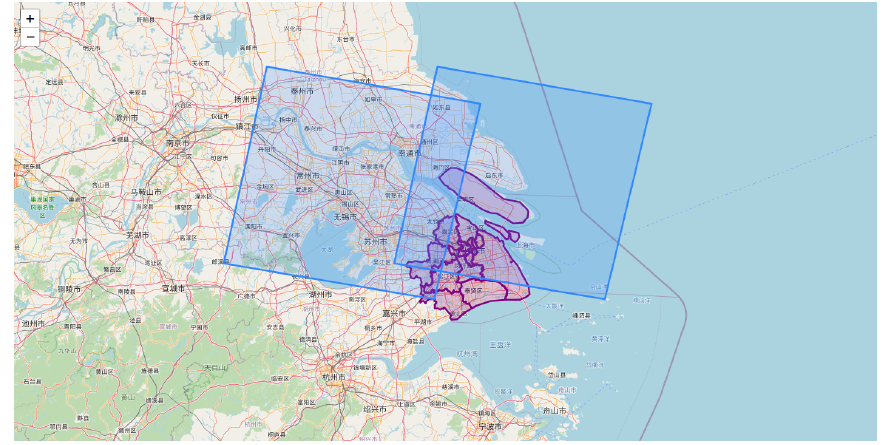
Figure 2: Landsat satellite tiles that cover the Area of